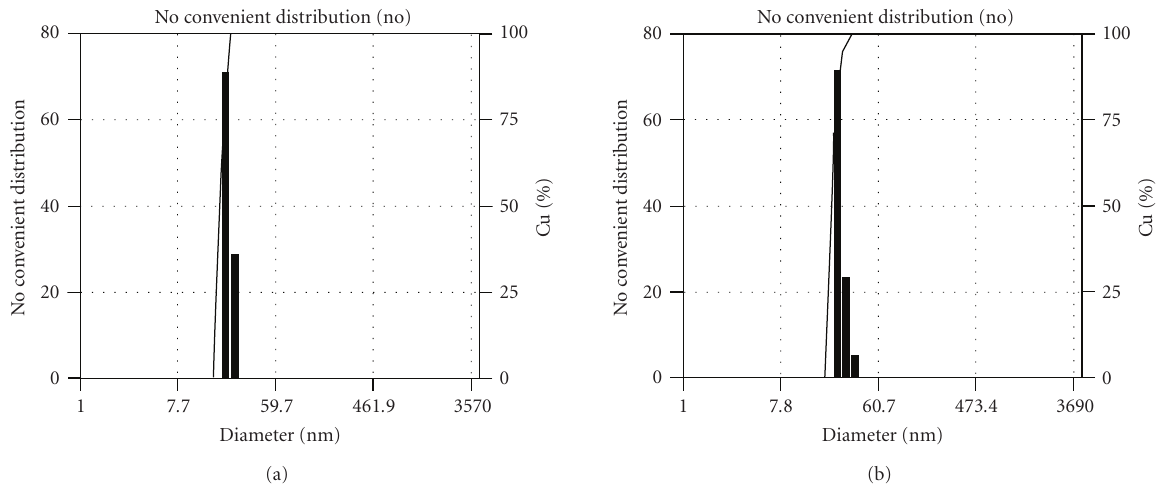
Figure 5: Particle size distribution profiles of 2-pyrrolidone-coated SPIONs (a), PVLA-coated SPIONs